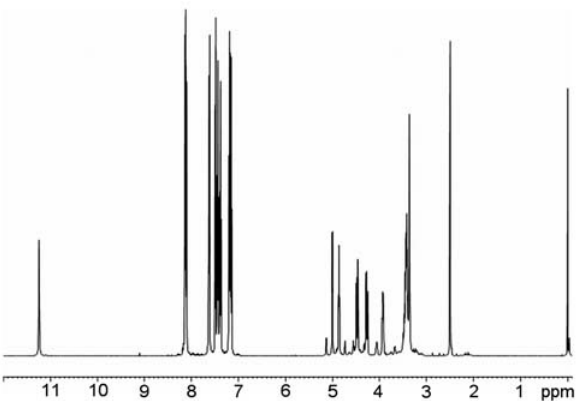
Fig. 1. 1 H-NMR spectrum of post-reaction mixture obtained from the C : GL = 1 : 1 molar ratio